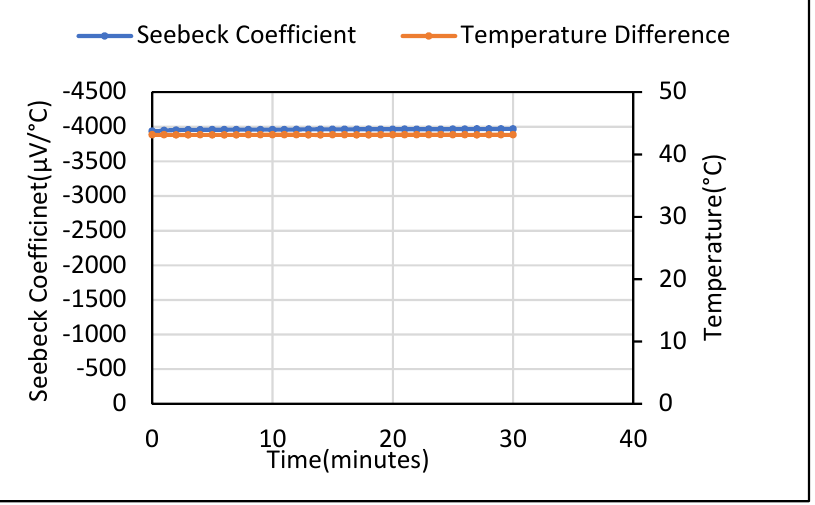
Figure 11. Seebeck coefficient for saturated 5 wt.% Fe 2 O 3 cement composites for 30 min time period. The voltage obtained was measured in both directions, i.e., from the hot to cold end and vice versa. The magnitude of voltage from both directions was found to be the same. The hot to cold voltage values showed a positive sign while the reverse order showed a negative sign. These results using the instrument were confirmed using two multimeters which give confidence that the sources of error have been eliminated. Another set of tests carried out from the hot to cold (positive) end for 24 h is shown in Figure